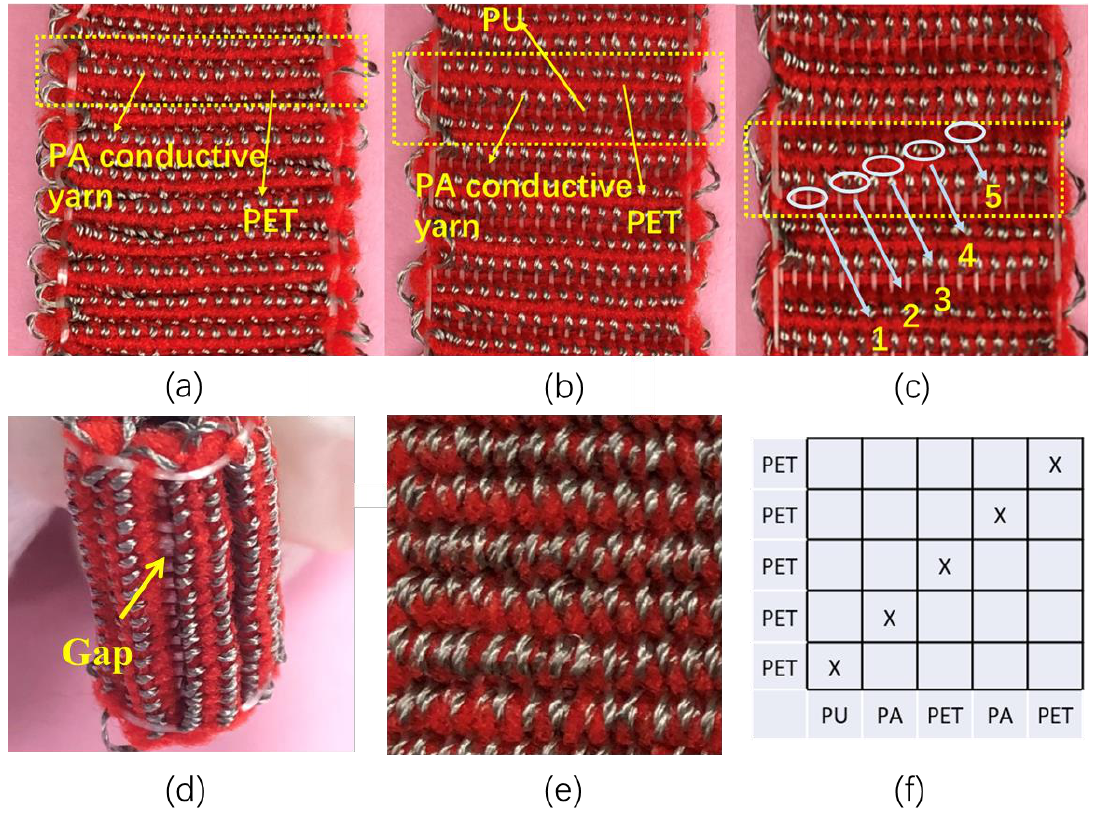
8 of 16 Figure 3. ( a ) The working mechanism of SWF − TENG with a satin weave, ( i ) In the original state without stretch; ( ii ) The SWF−TENG is gradually stretched; ( iii ) The SWF−TENG is stretched to the largest deformation; ( iv ) The SWF−TENG is recovering to the original state; ( b , c ) Electrical output performances of SWF − TENG with s atin structure. Different from the SWF-TENG with a satin weave, the working mechanism of the twill weave structure has changed. As shown in Figure 4a – e, the digital photographs of the SWF-TENG with twill weave are presented. Same as with a satin weave, the twill weave structure also has a gap that is visible at the stretching state and invisible at the original state (Figure 4b,d). It exists between two adjacent weft weave repeat units. The PET and PA conductive yarn beside the gap will contact and separate from each other during stretching – releasing motion, which generated electricity. The back side of SWF-TENG with twill weave is covered with loops of PET filaments and PA conductive